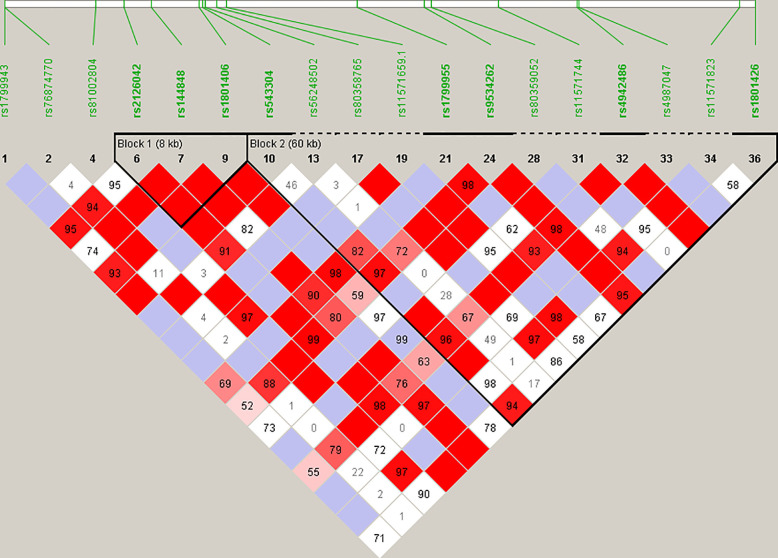
Linkage disequilibrium (LD) plot constructed for BRCA2 with Haploview 4.2, using a total of 18 SNPs. Schematic diagram of the gene on chromosome 13. Marker variants and their relative locations are represented by vertical lines or boxes (SNP number is indicated above each box together with the rs ID). The LD plot is based on the logarithm of the odds (LOD score) and average obsolete value (D’) to characterize the LD between two SNPs in the population data. The diamond color where two SNPs intersect reflected the LD’s level, with bright red indicating very strong LD (LOD = 2, D’ = 1), a white color for no LD (LOD < 2, D’ < 1), with pink-red (LOD = 2, D’ < 1) and blue (LOD < 2, D’ = 1) for an intermediate LD.